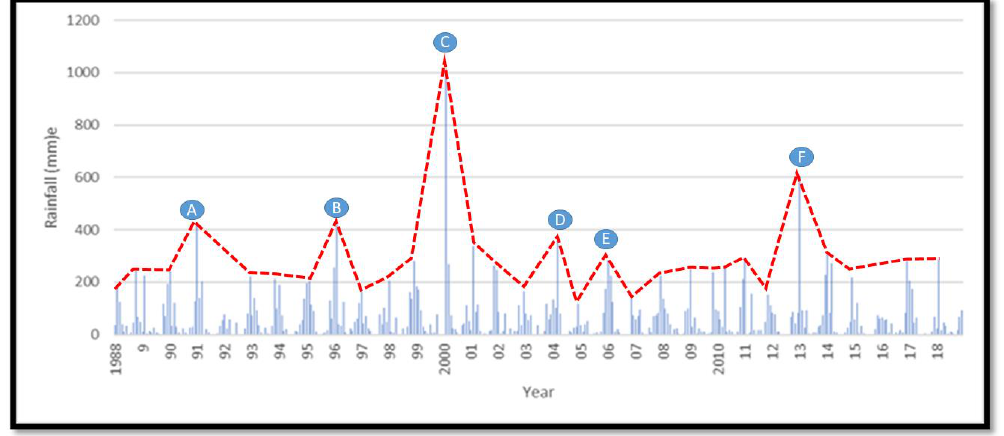
Figure 9. Monthly rainfall statistic for Thohoyandou area from the year 1988 to 2018.